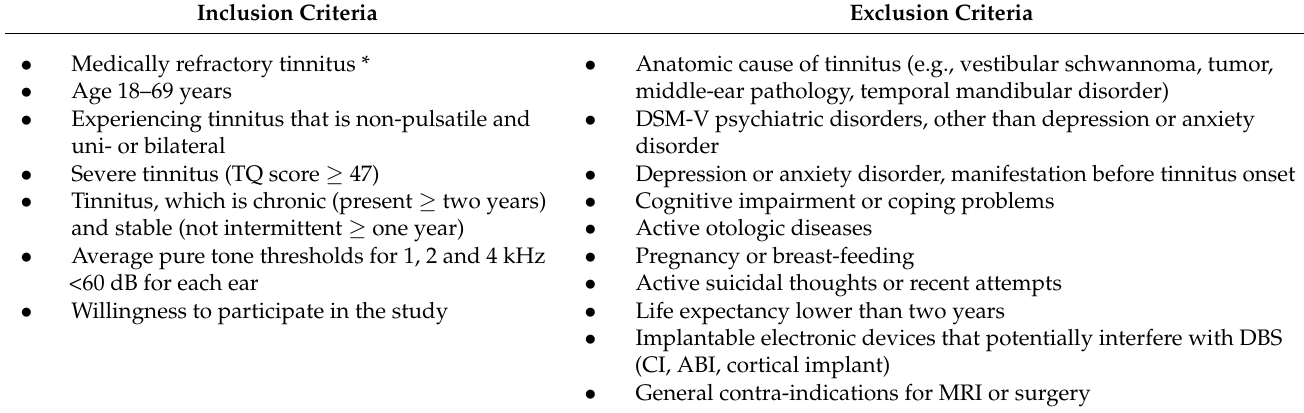
Table 2. Eligibility criteria. TQ, Tinnitus Questionnaire; DBS, Deep Brain Stimulation; CI, Cochlear Implant; ABI, Auditory Brainstem